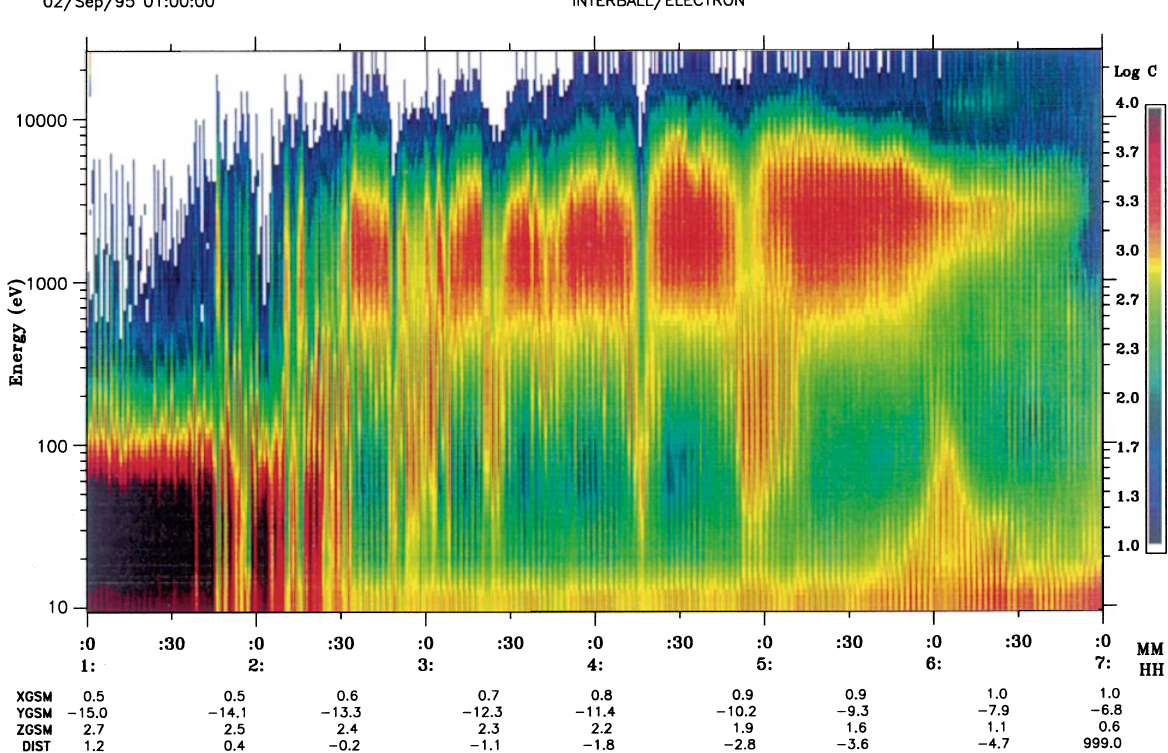
magnetic field is roughly parallel to the Z -axis, so that the pitch- GSM angle range (cid:24) 0 (cid:176) (cid:255) 180 (cid:176) is scanned every minute due to the satellite rotation. On the left-hand side of the figure, the dense and low-energy magnetosheath plasma is seen as a black area on